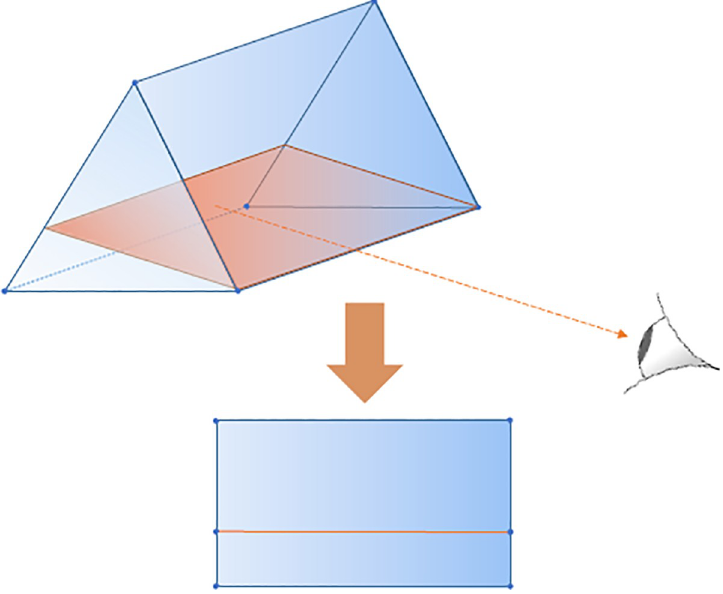
Fig 3. The two populations’ combined state space is a uniform triangular prism. This prism is divided into two regions by a plane on which fighters and yielders do equally well. Using the line of intersection of this plane with a triangular side of the prism as line-of-sight, the prism can be visualized as a rectangle in which the defenders’ indifference plane is a line parallel to the base of the